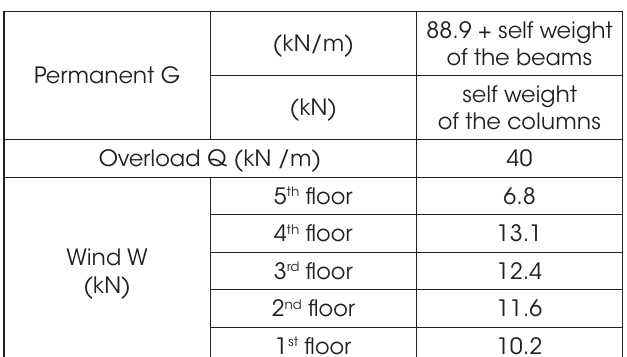
Characteristic forces of the frame, adapted from Meireles Neto [8]